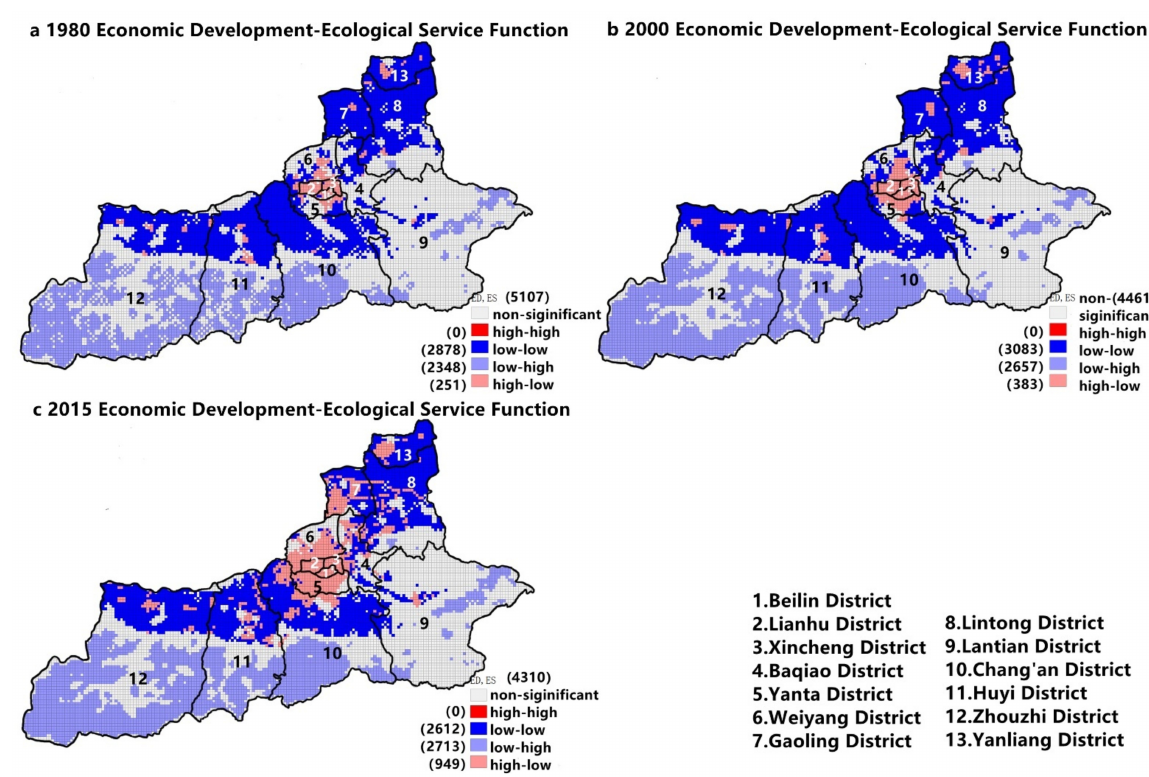
Figure 6. LISA Map of Land System Economic Development—Ecological Service Function. In Xi’an city from 1980 to 2015.